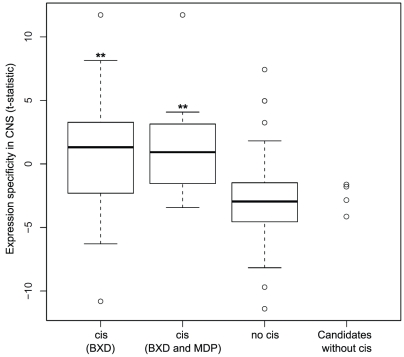
CNS expression specificity of candidate regulators in Qrr1.CNS specificity of expression is expressed as t-test statistics comparing expression in CNS tissues against all tissues tested. Box plots show distributions of t-scores for genes mapping to Qrr1. cis
 (BXD): subset of genes with a cis-eQTL in BXD; cis
 (BXD+MDP): genes with a cis-eQTL in both BXD and MDP; no
cis: genes localized in Qrr1 but without a cis-eQTL; Candidates without
cis: candidate causal genes (distant eQTL only) without a cis-eQTL.